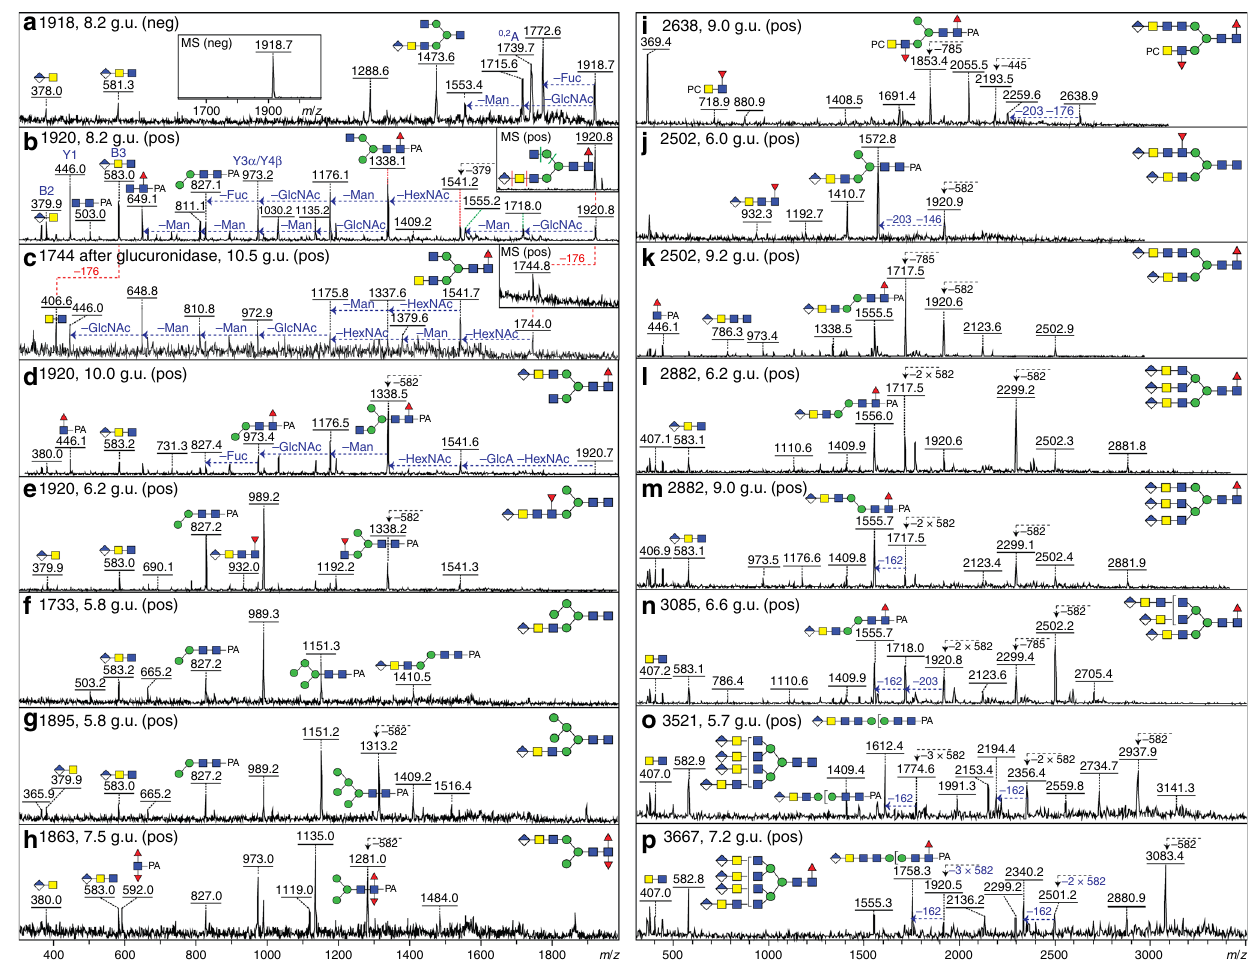
Fig. 6 Example MS/MS data of glucuronylated N-glycans. a – c MALDI-TOF – MS/MS (with MS in insets) of the 2D-HPLC puri fi ed m / z 1918 (negative) or 1920 (positive) glycan eluting at 8.2 g.u. (Fig. 5b) before ( a , b ) and after ( c ) Helix pomatia β -glucuronidase treatment; removal of the glucuronic acid residue correlates with loss of 176 Da from the parent and of the positive mode B-fragment ion at m / z 583 (HexA 1 HexNAc 2 ). In general, the positive ion mode MS/MS spectra of the protonated forms of glucuronylated glycans were more intense and more informative than the negative-ion mode MS/MS spectra, despite the excellent ionisation in negative mode of the parent species. d – i Positive mode MS/MS of monoglucuronylated N-glycans, including two isomeric forms of m / z 1920 differing in the position of the fucose residue (as shown by the m / z 932 HexA 1 HexNAc 3 Fuc 1 fragment for one form), two hybrid, one core di-fucosylated and one phosphorylcholine-modi fi ed structures found in RP-amide fractions derived from HIAX anionic pools b , c and h ; the presence of an upper arm antenna on the di-fucosylated glycan ( h ) is compatible with the requirement of nematode core α 1,3-fucosyltransferase for an unsubstituted α 1,3-mannose residue, whereas the m / z 592 Y-fragment de fi nes the core difucose modi fi cation (see also Supplementary Figure 5B and C). j – p Positive ion mode MS/MS of 2D-HPLC-puri fi ed di-, tri- and tetra-glucuronylated N-glycans (see Fig. 5h, j – l). Losses of one, two or three HexA 1 HexNAc 2-3 motifs ( Δ m / z 582 or 785) are indicated in addition to selected antennal B- and pyridylamino-containing Y-fragment ions. The concluded structures re fl ect the presence of corresponding non-glucuronylated tri- and tetra-antennary forms in the neutral pools with 4-linked GlcNAc leading to later RP-amide elution than a 6-linked GlcNAc. The two m / z 2502 glycans ( j , k ) differ in the location of the fucose residue, while the m / z 3521 glycan ( o ) elutes earlier than that of m / z 3667 ( p ) due to the retentive effect of the core α 1,6-fucose; for further characterisation of bi-antennary forms